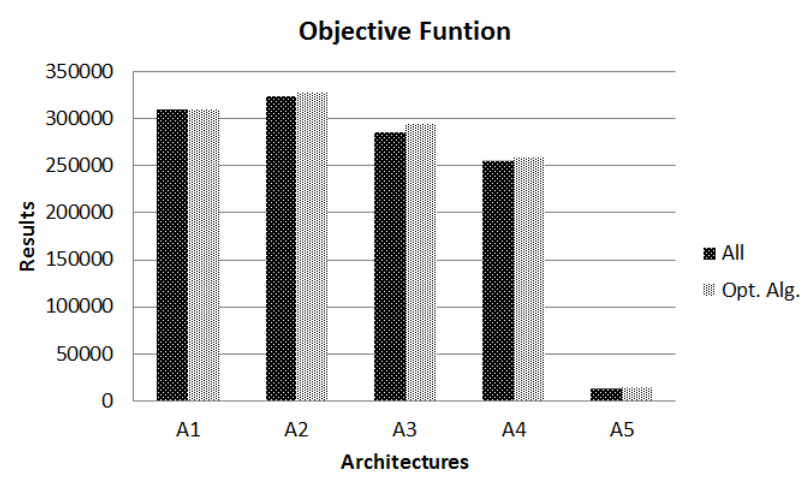
Figure 14. Objective function.